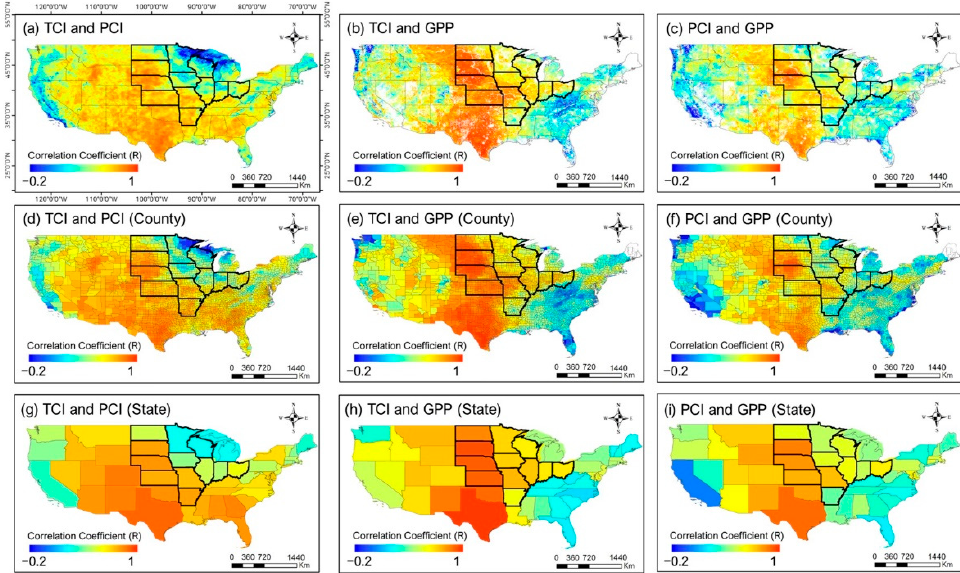
Figure 2. Correlations of annual variation between TCI and PCI, TCI and GPP, and PCI and GPP for pixel level ( a – c ), county level ( d – f ), and state level ( g – i ) for the average of July and August. Their significance maps for the correlation are represented in Figure A1.